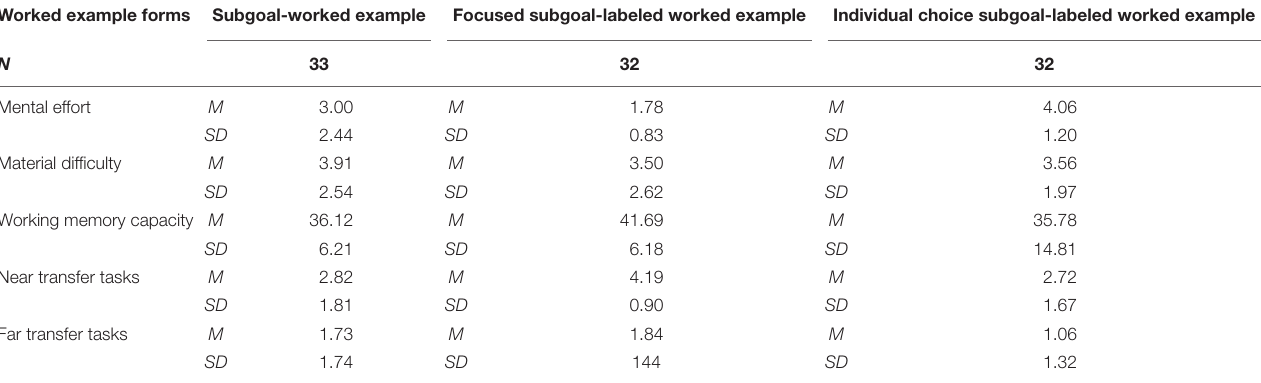
TABLE 2 | Participants’ cognitive load level, working memory capacity and transfer scores in the three worked example forms. Worked example forms Subgoal-worked example Focused subgoal-labeled worked